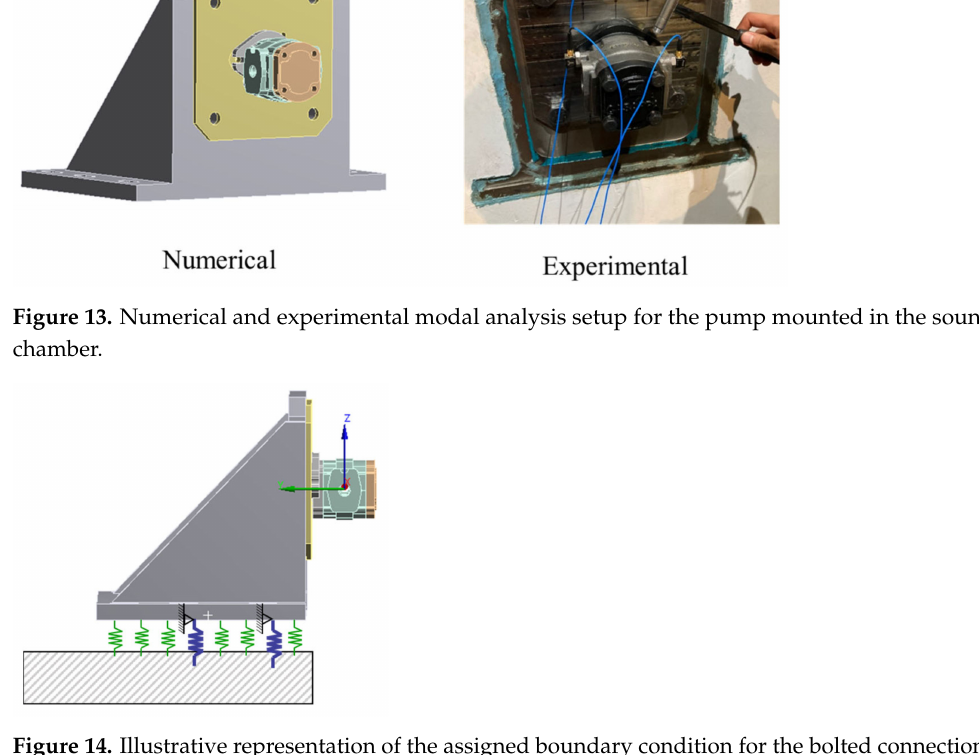
Figure 14. Illustrative representation of the assigned boundary condition for the bolted connections of the mounting